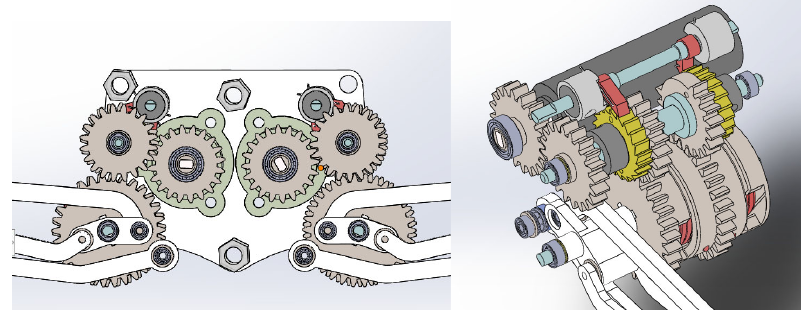
Figure 9. 3D structural model of transmission structure.